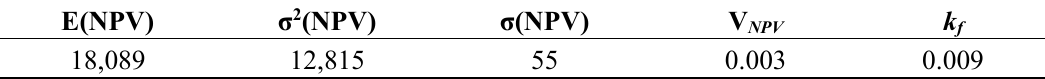
Table 4. Calculation of the risk premium for afforestation ( k f